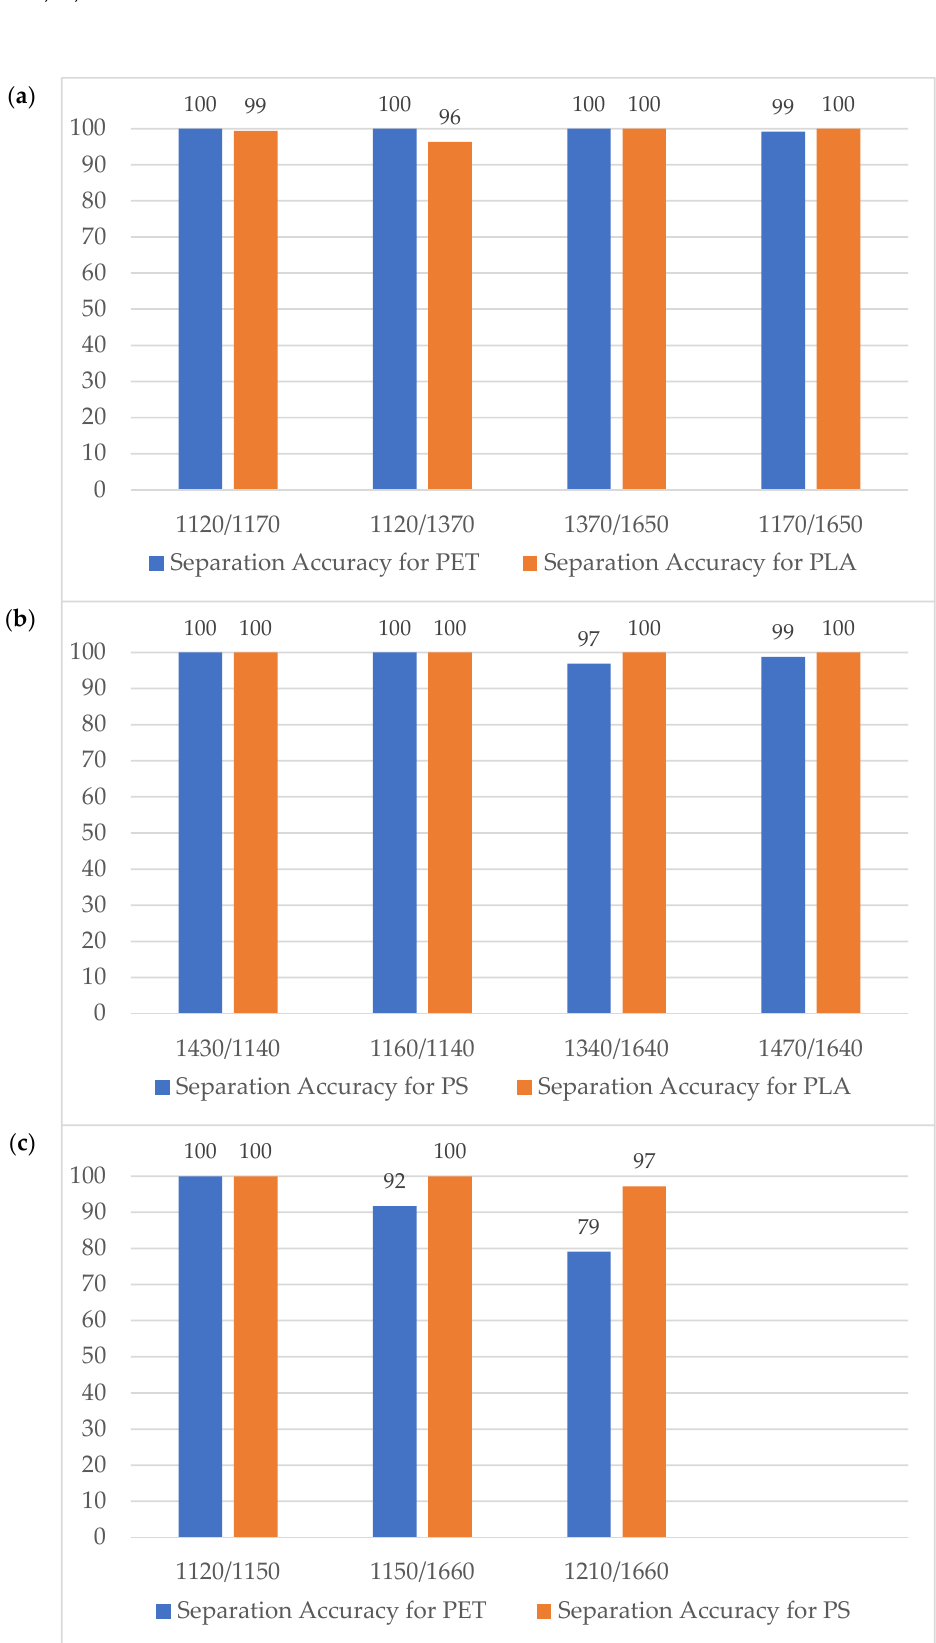
Figure 9. Accuracy assessment of spectral indices computed employing the reflectance values without post-processing for pairs ( a ) PET-PLA; ( b ) PS-PLA; ( c ) PET-PS.